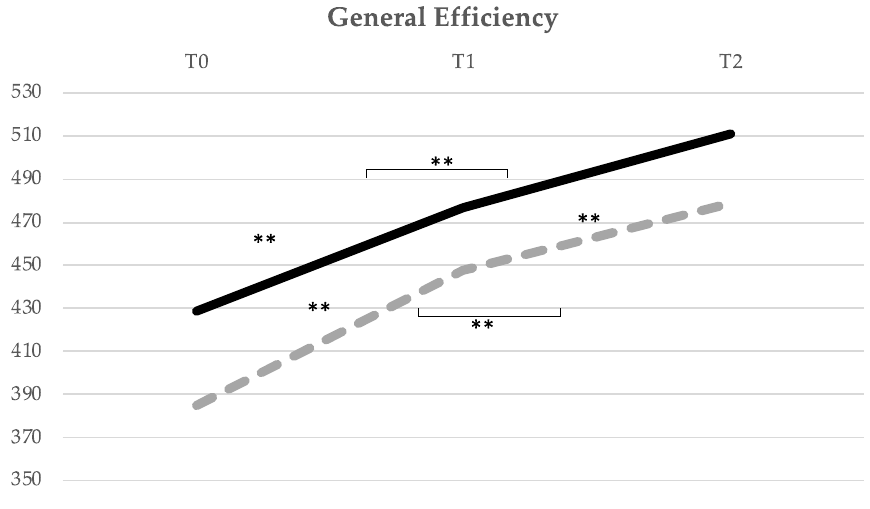
Figure 2. Evolution of the General Efficiency mean score over time (from T0 to T1, i.e., from pre- to post-acute exercise; and from T1 to T2, i.e., from post-acute exercise to post-chronic exercise). ** Indicates significant differences for p < 0.01.